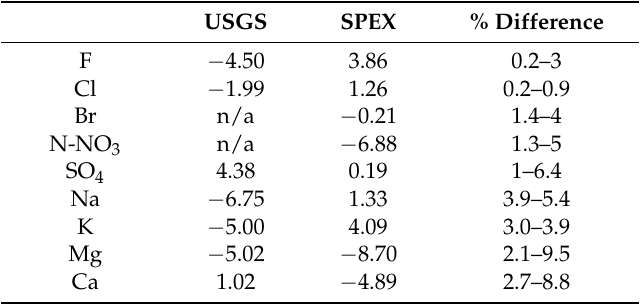
Table A1. Comparison of most probably values for a USGS inter laboratory sample with our calculated values based on SPEX